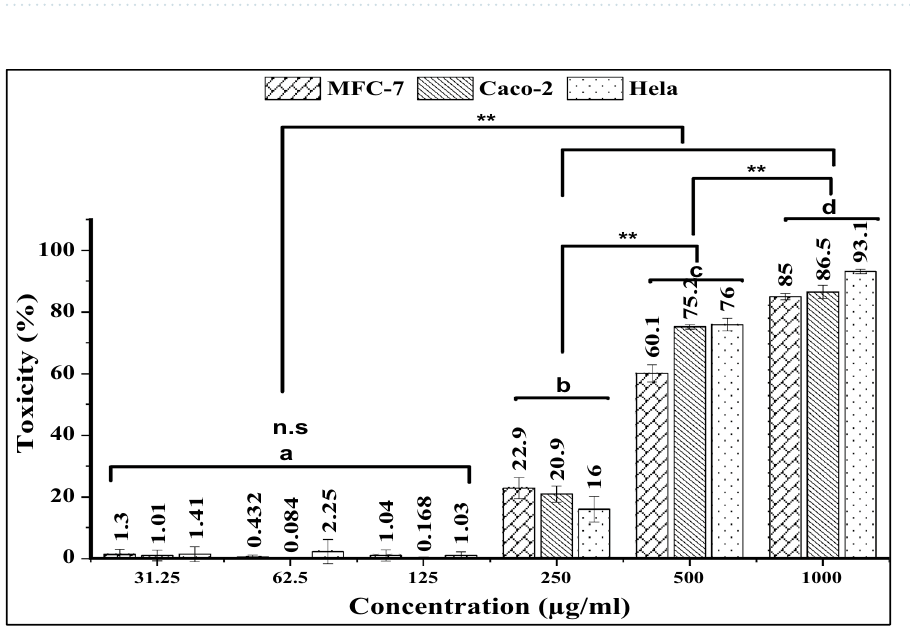
Figure 12. Cytotoxicity of Kocuria sp. RAM1 carotenoids against MCF-7, Caco-2 and Hela cell lines. The letters a, b, c and d represent significant differences among different homogeneous subsets identified by the post hoc test for p < 0.05. (**)Significant at p < 0.01; n.s non-significant. The data represent the mean ± SD (n =